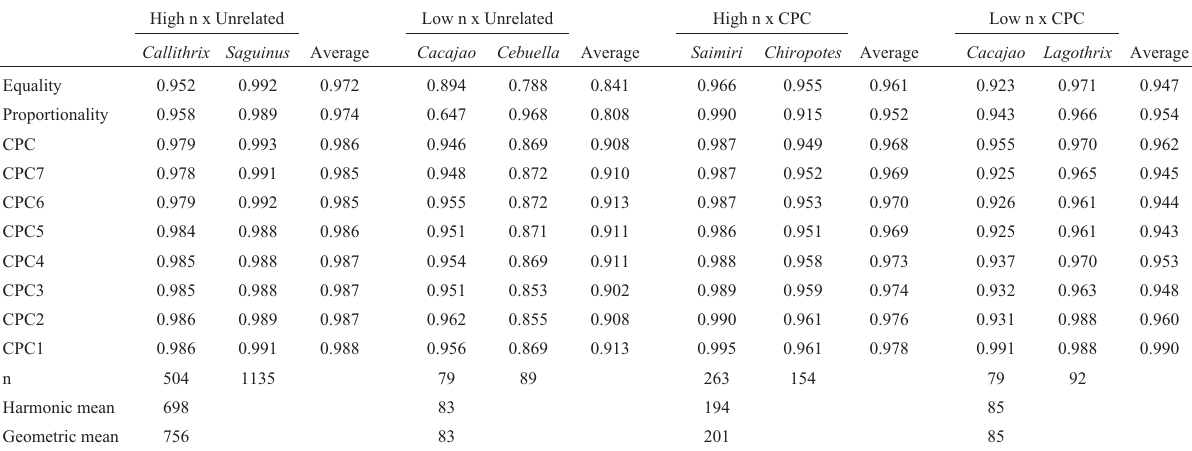
Table 2 - Random skewers results for the comparison between original and reconstructed covariance matrices at each step in the CPC hierarchy for the four selected pairwise comparisons of high or low sample sizes with unrelated or CPC structural similarity. For each genus, we present the average RS vector correlation between reconstructed matrices at each step in the hierarchy. The average RS vector correlation between each pair of genera is also shown. Sample size for each matrix is presented at the bottom of the table as well as the harmonic and geometric means of the sample